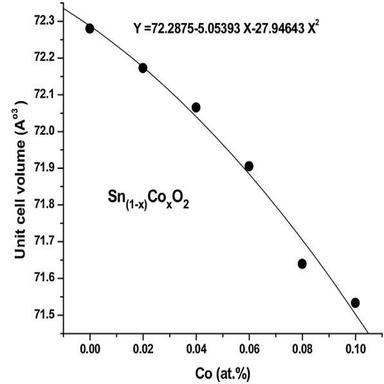
Unit cell volume (A3) as a function of SnO2 nanoparticles doped with Co.